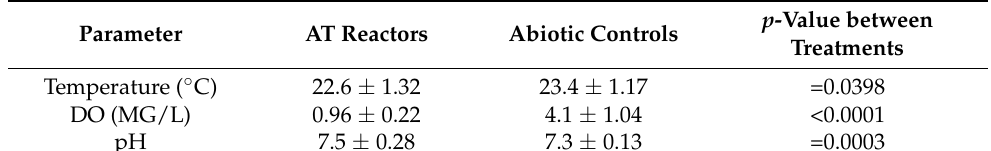
Table 3. Reactor environmental conditions. The mean ± SD of the temperature, DO, and pH in the AT reactors and the abiotic control reactors during the study.